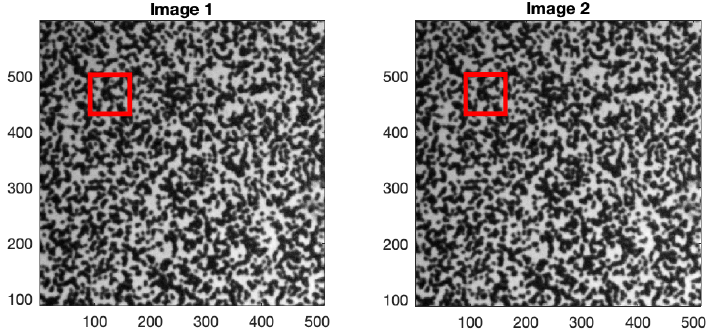
Figure 9. Two images of the DIC Challenge database [19], each with resolution 512 × 512 pixels. The the red windows correspond to an example of template for the QSF